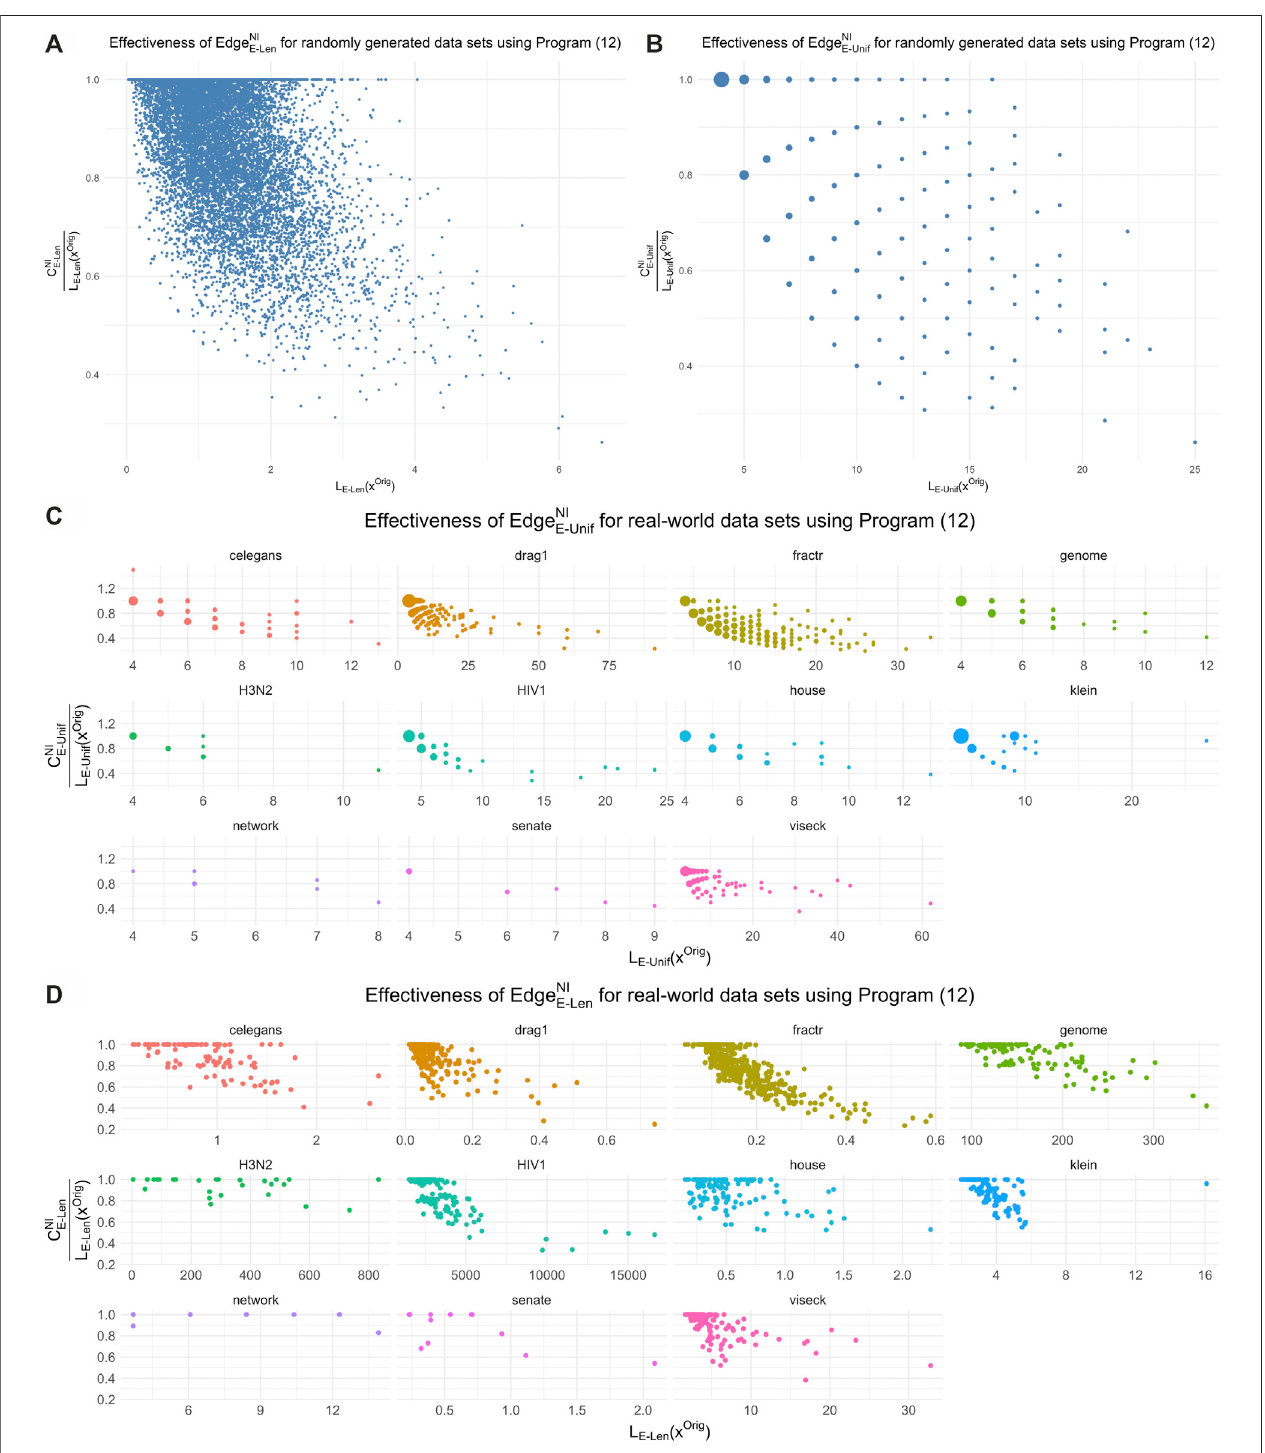
FIGURE12| Theeffectivenessoflength-weightedanduniform-weightedoptimizationforthedatasetsin Sections5.1 and 5.2 inreducingthesizeoftheoriginalcycle representativefoundbythepersistencealgorithm.Ineachsub fi gure,thehorizontalaxisisthesizeoftheoriginalrepresentativeandtheverticalaxisistheratiobetweenthesize of the optimal representative and the size of the original representative. The uniform-weighted graphs appear more sparsebecause reductions in the cost L T - Unif ( x Orig ) can only come in multiples of the reciprocal of the original length. The node size in the uniform-weighted graphs corresponds to the number of overlapping points.